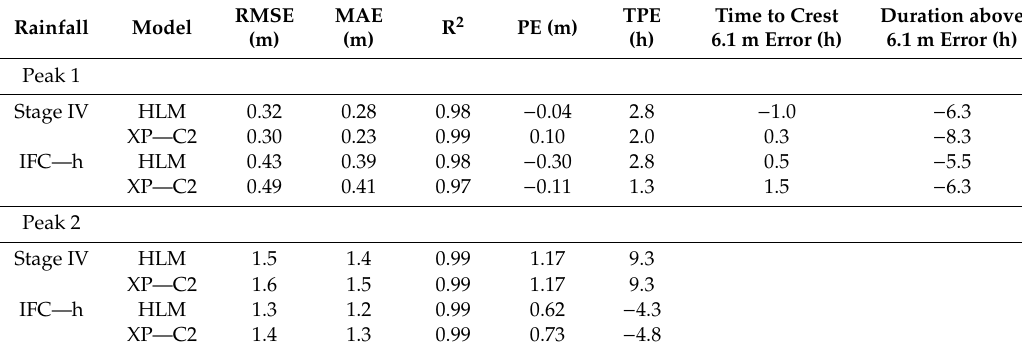
Table 2. Statistical analysis comparing the simulated stages to USGS observations for the first and second peaks of the July 2010 flood and the time to crest and the duration above the NWS major flood stage (6.1 m) for the first peak for model configurations HLM and XP—C2, using both Stage IV and IFC radar rainfall products.